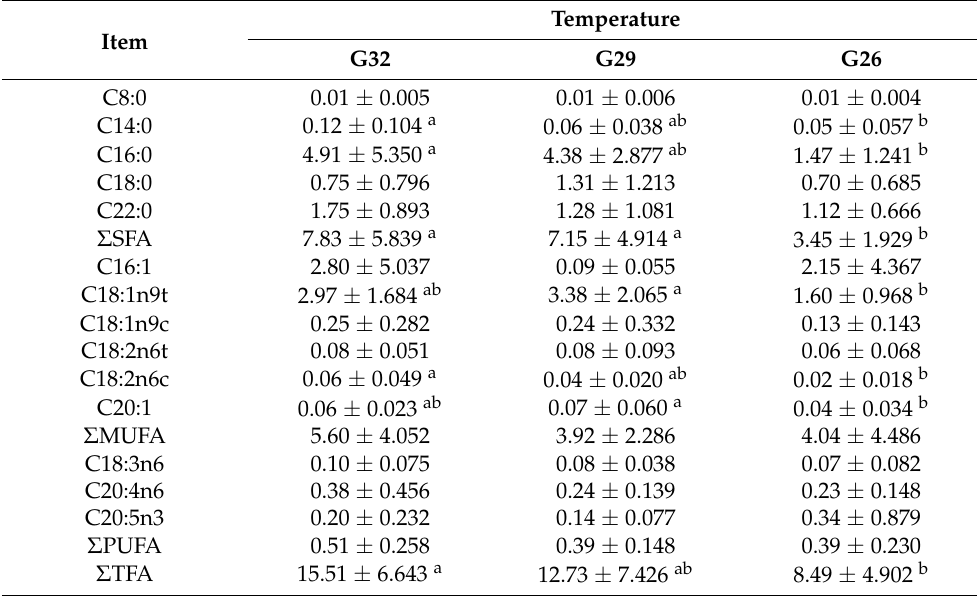
Table 3. Effects of temperature on fatty acid content of yolk sac fluid.